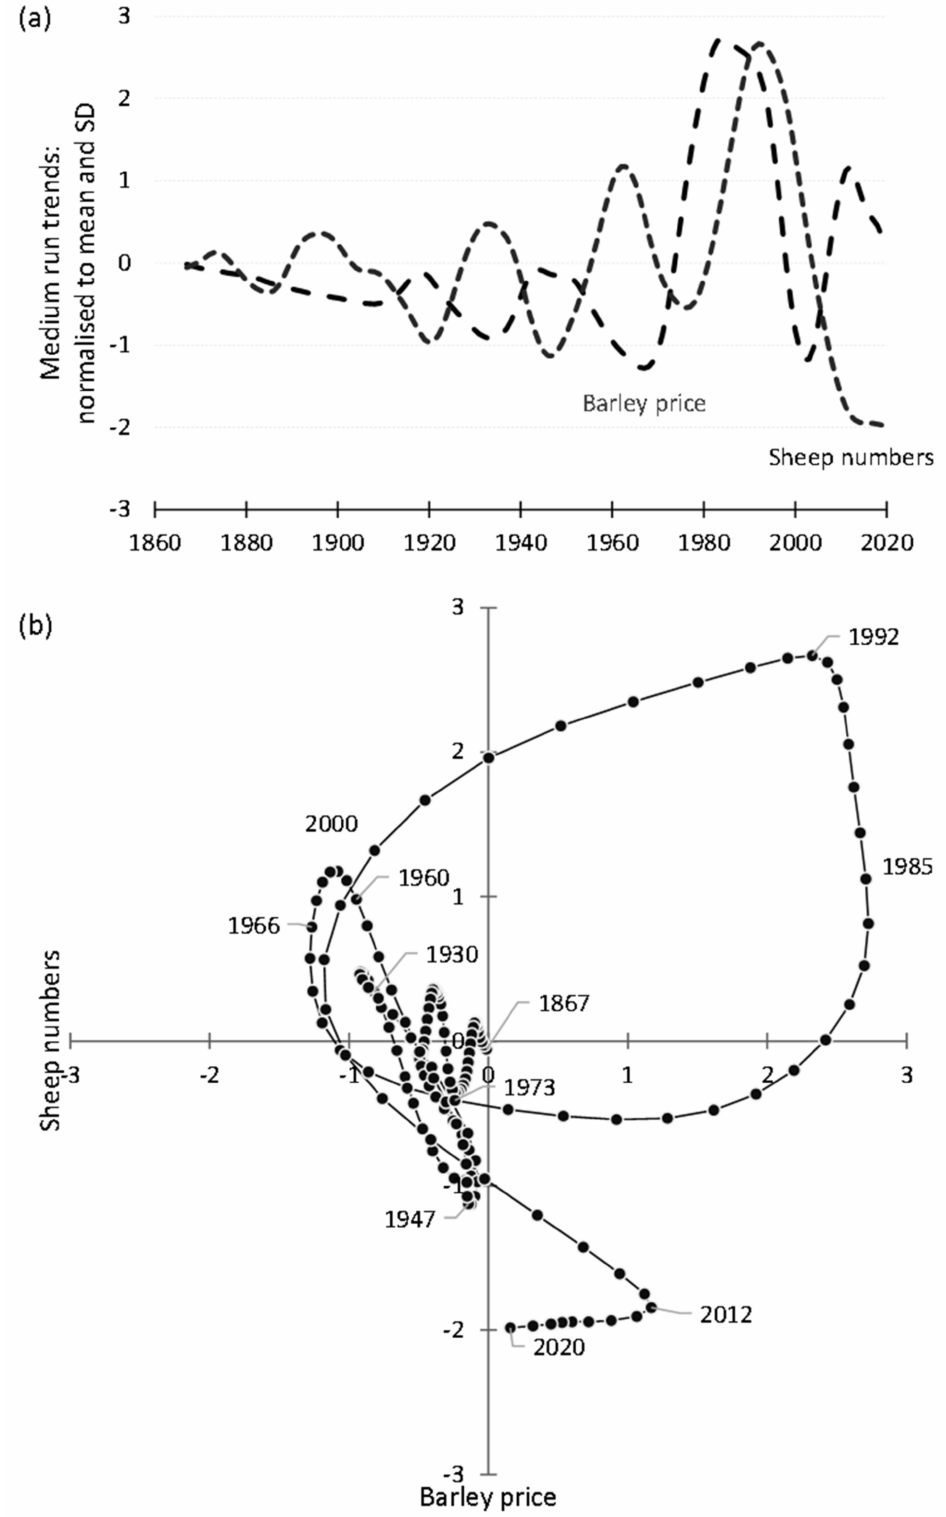
Figure 9. Medium-term patterns of variation for barley price and sheep numbers in Scotland (1867–2020) as ( a ) time series and ( b ) phase plots. Note: the variables are normalized to account for differences in